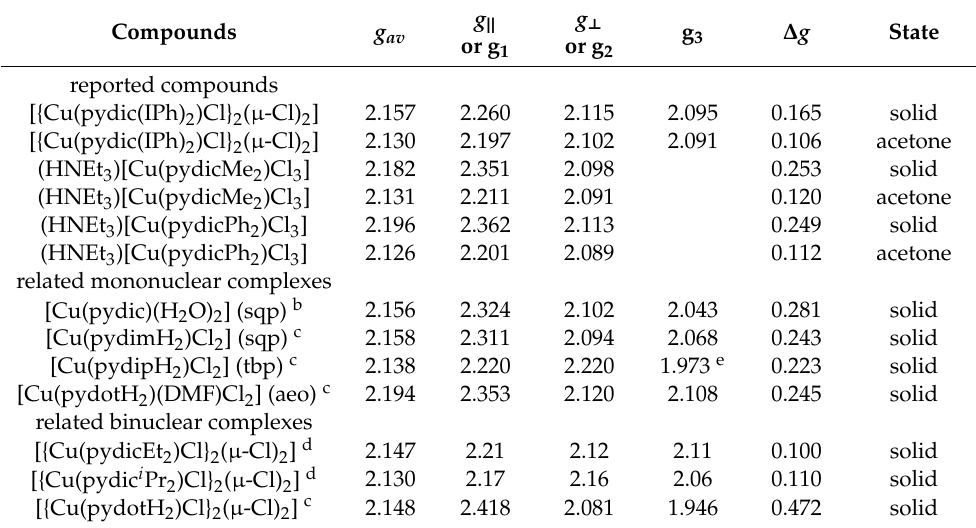
Figure 8. X-band EPR spectra of (HNEt 3 )[Cu(pydicMe 2 )Cl 3 ] and (HNEt 3 )[Cu(pydicPh 2 )Cl 3 ]. ( A ) in the solid, ( B ) in acetone solution measured at 298 K. Table 3. X-band EPR data of the reported and comparable Cu II complexes a .